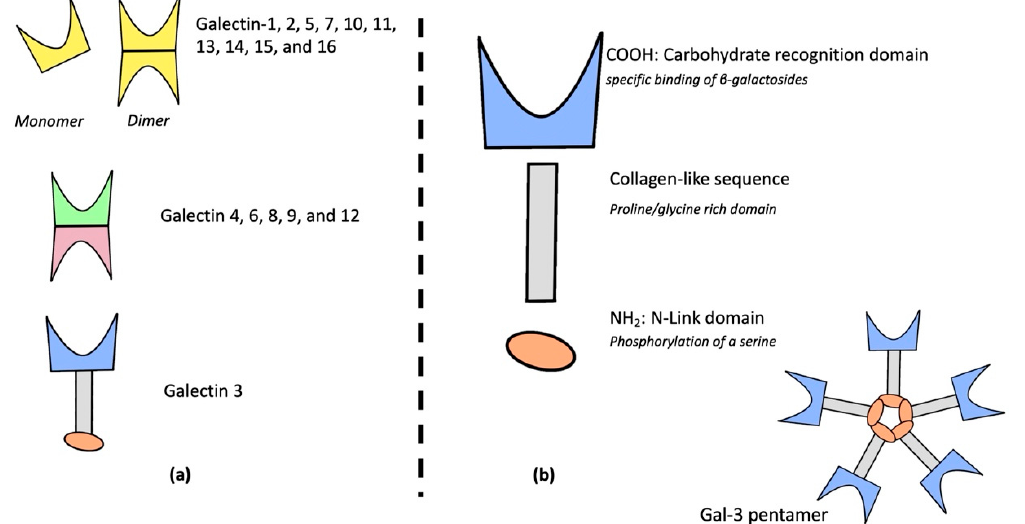
Figure 1. Galectins’ family structure ( a ), galectin-3 chimeric and specific structure ( b ).